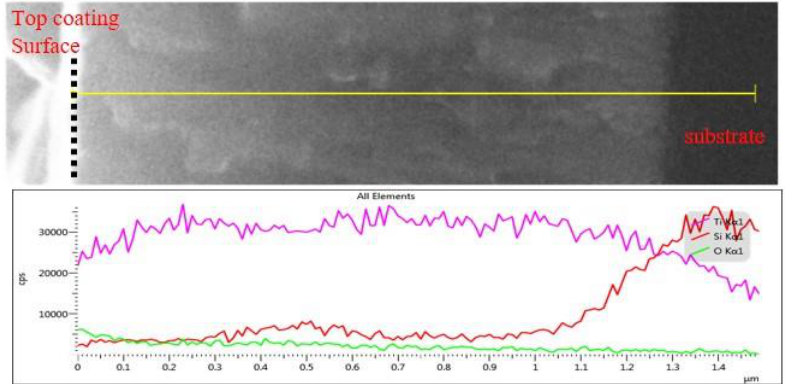
Figure 3. Linear elemental scan EDS analysis of the arc-PVD TiO x coating.